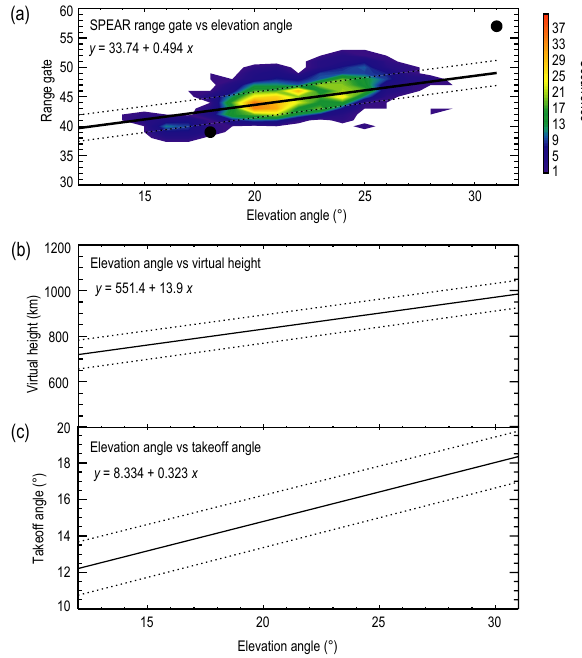
Fig. 6. (a) An occurrence plot of the range gate in which artificially- stimulated backscatter is induced in the Hankasalmi field of view vs. the elevation angle of the backscatter, for all backscatter observed by the Hankasalmi-SPEAR combination. The black dots repre- sent previous data from the Þykkvibær-Tromsø experiments. See text for details. (b) Best fit lines for assumed irregularity pseudo- virtual height vs. measured elevation angle for the data presented in panel (a). The dotted lines represent ± 1 standard deviation of the occurrence distribution. (c) As for (b), but for assumed takeoff angle vs. measured elevation